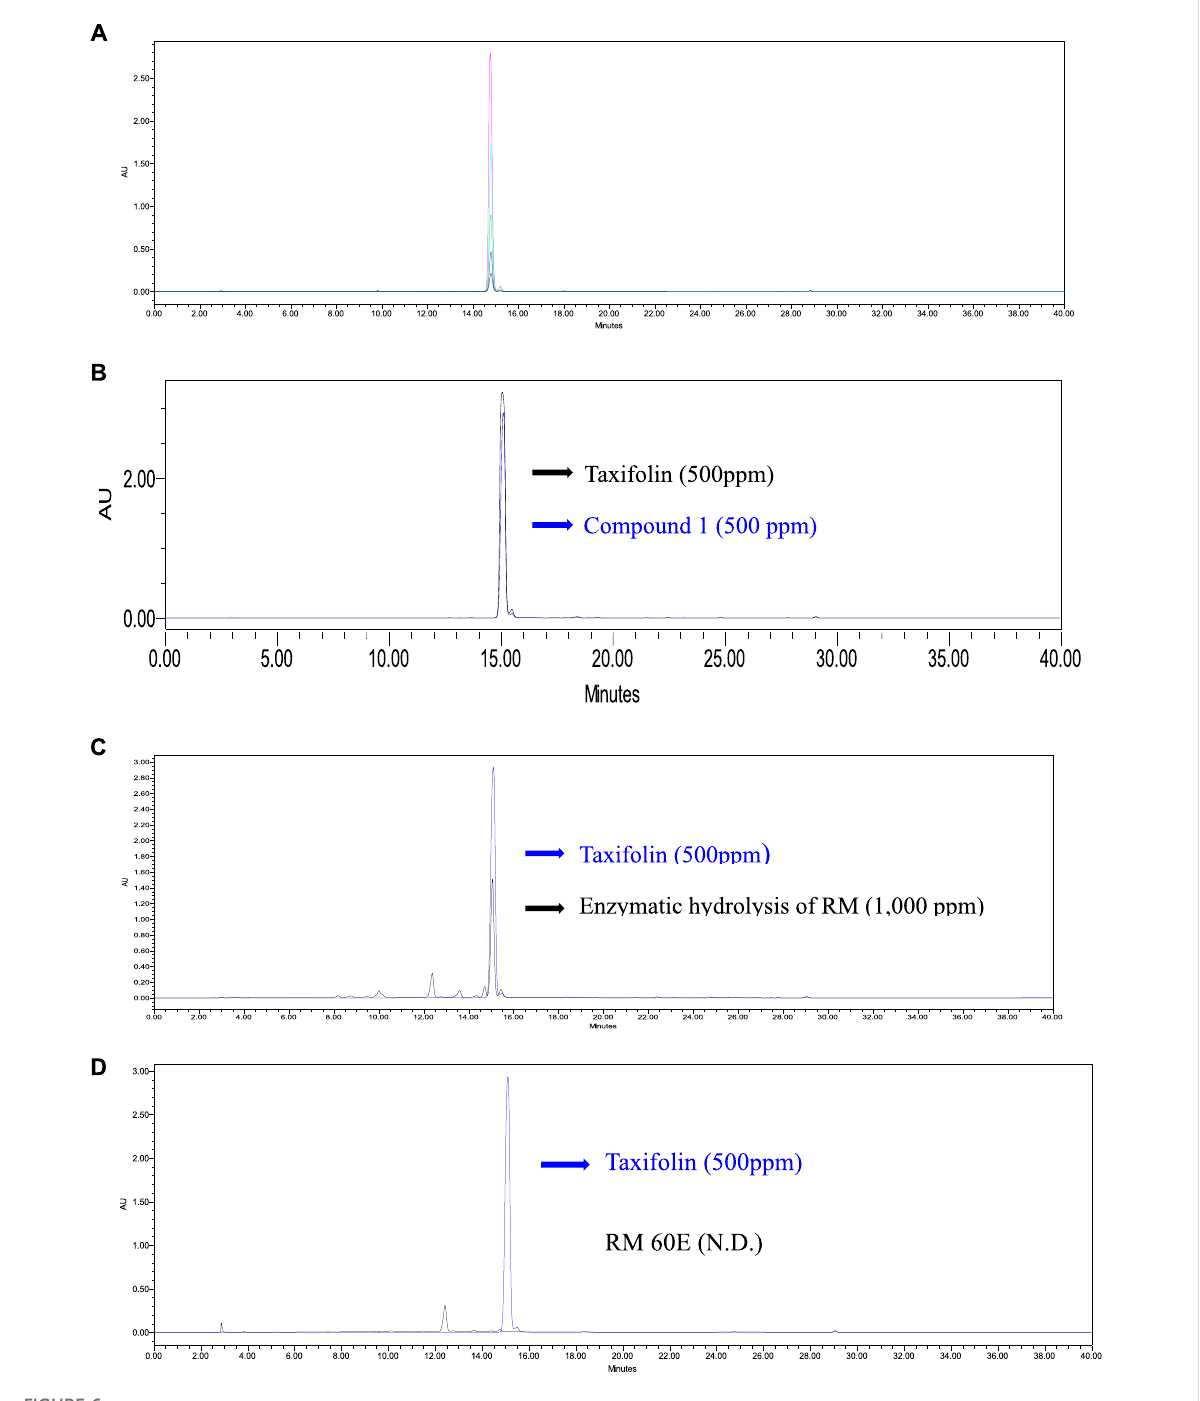
HPLC chromatogram of (A) taxifolin. Black (31.25 ppm), blue (62.5 ppm), green (125 ppm), skyblue (250 ppm), pink (500 ppm), (B) compound 1 (500 ppm). Black (taxifolin; 500 ppm), blue (compound 1; 500 ppm) (C) enzymatic hydrolysis of RM (1,000 ppm). Black (enzymatic hydrolysis of RM; 500 ppm), blue (taxifolin; 500 ppm) and (D) RM 60E. Black (RM 60E; 1,000 ppm), blue (taxifolin; 500